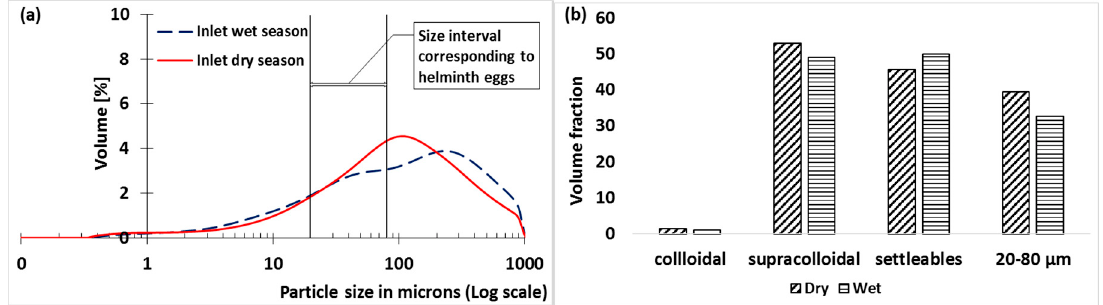
Figure 2. Incoming particle sizes for wet and dry season: ( a ) volume PSD; ( b ) volume fractions of different size